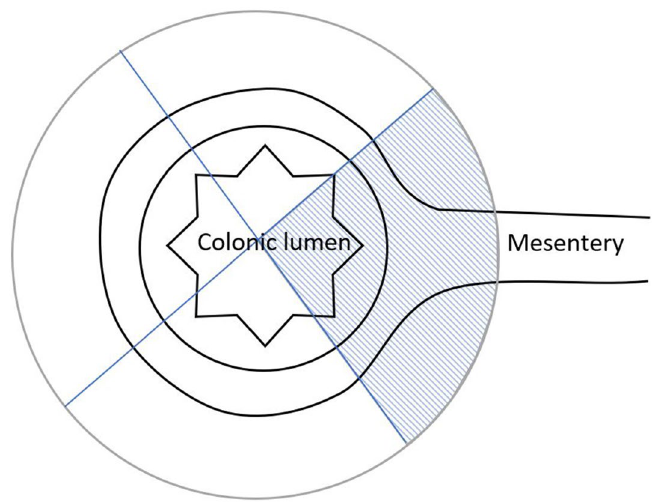
Figure 1. Any tumour in the marked area was considered mesenteric anything outside was considered anti-